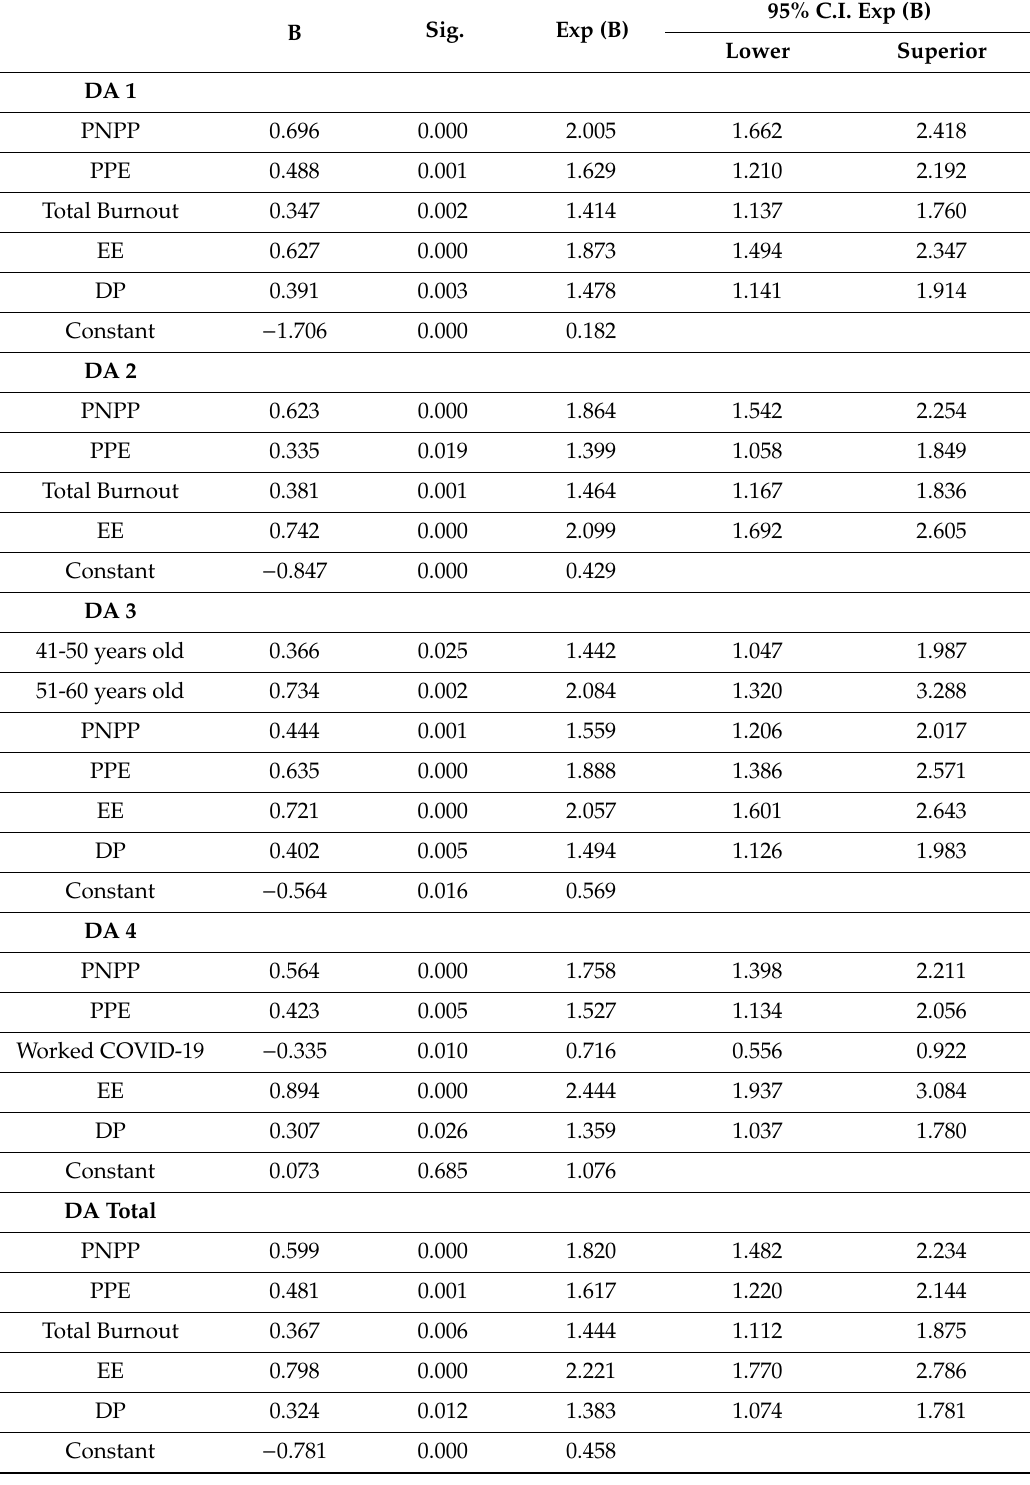
Table 3. Summary of binary logistic regression